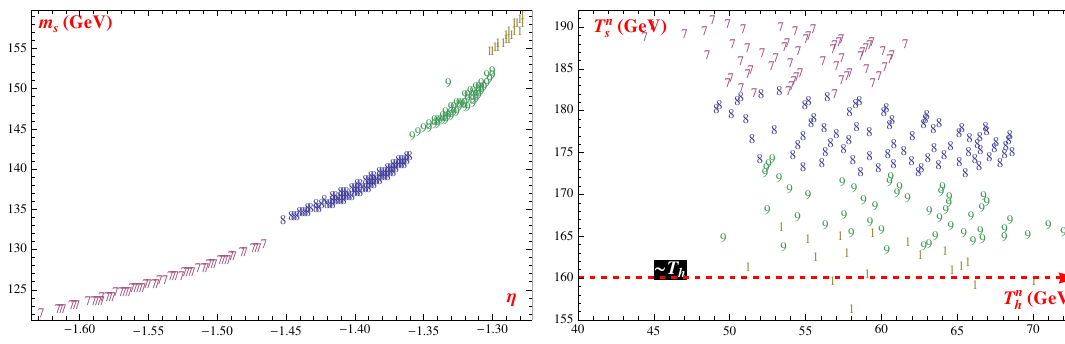
Figure 6 . (Left panel): a demonstration on the viable three-step EWPT strips on the ( (cid:17); m s ) plane with (cid:21) sh = 0 : 24, varying (cid:21) s = 0 : 7 ; 0 : 8 ; 0 : 9 ; 1 : 0; for easy identi(cid:12)cation we plot the region with points labelled by numbers 7 ; 8 : : : , respectively. The overall picture is consistent with the analytical analysis in the high-temperature expansion. (Right panel): distributions of two FOPT temperatures, T (cid:3) and T (cid:3) ; the red dashed line denotes T h , the typical second order PT temperature s h for (cid:10) 0 ! (cid:10) h